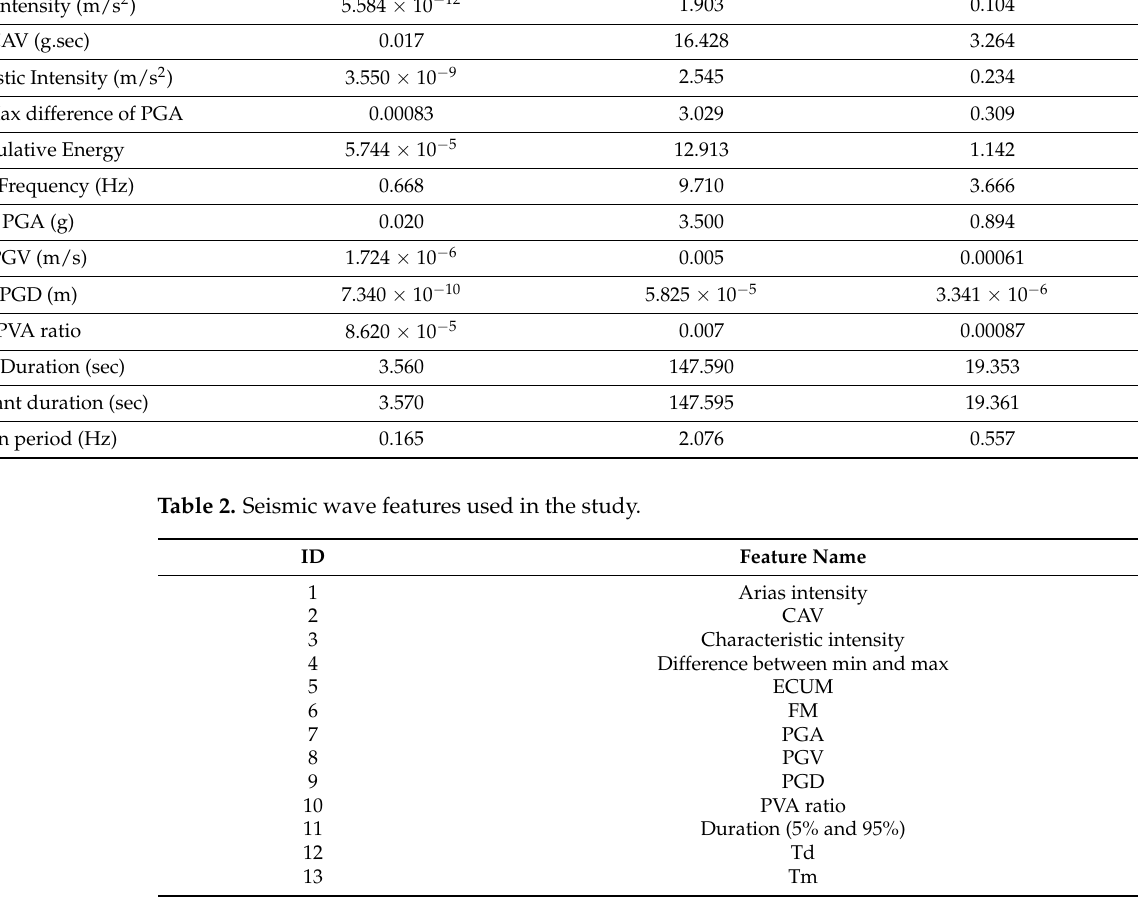
Table 3. Correlation analysis for the characteristics based on Pearson coefficients.